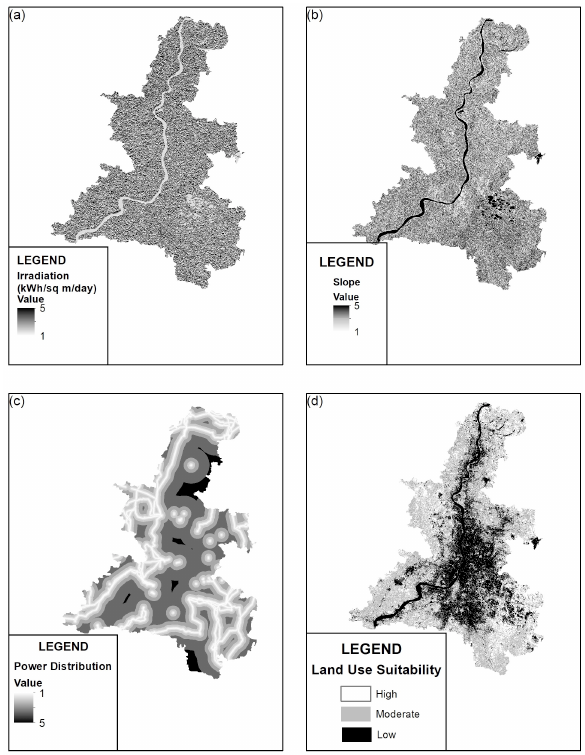
Figure 4 . Criteria selected for determining suitable zones for solar farm planning in KMA